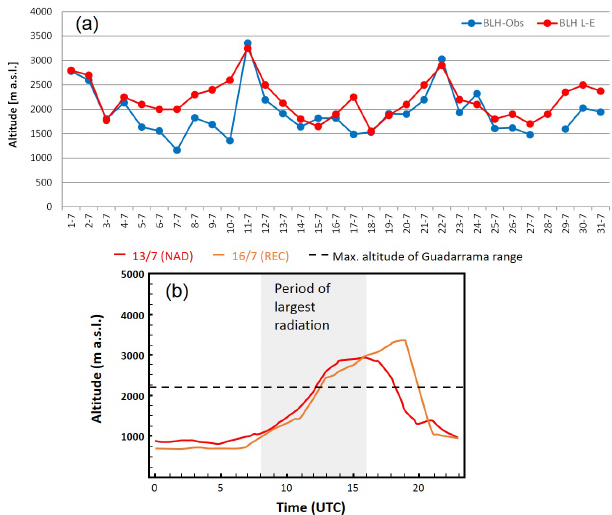
Figure 12. (a) Time series of the estimated and modelled midday BLH over Madrid airport for July 2016. Estimations calculated from the daily AEMET radio soundings using the simple parcel method. (b) Modelled BLH for 13 (NAD event) and 16 (REC event) July